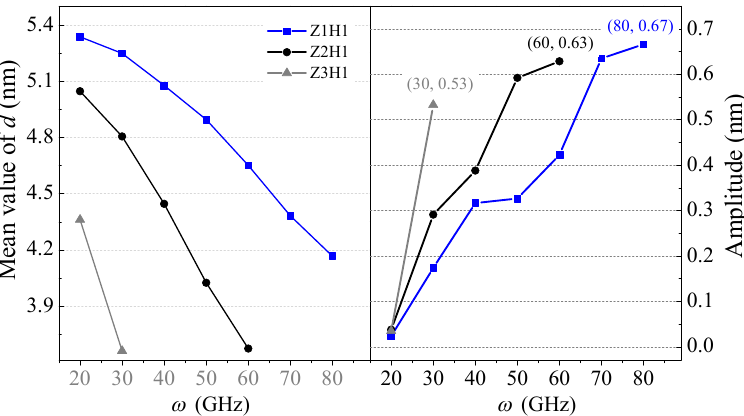
Figure 10. Equilibrium positions (mean values of d ) and oscillation amplitudes of the R-rotor connected with the HDPs that had di ff erent lengths at 8 K between 9 ns and 10 ns.